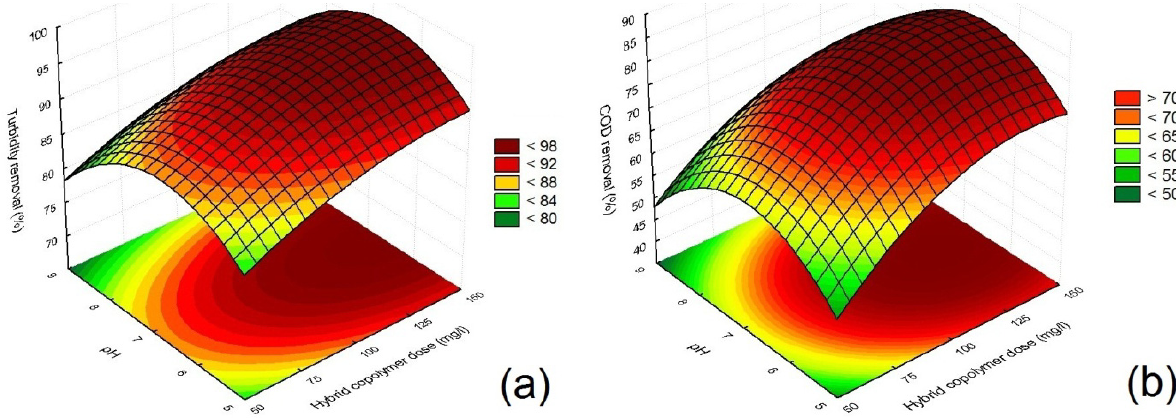
Figure 5. 3D surface plot for ( a ) turbidity removal; and ( b ) for COD